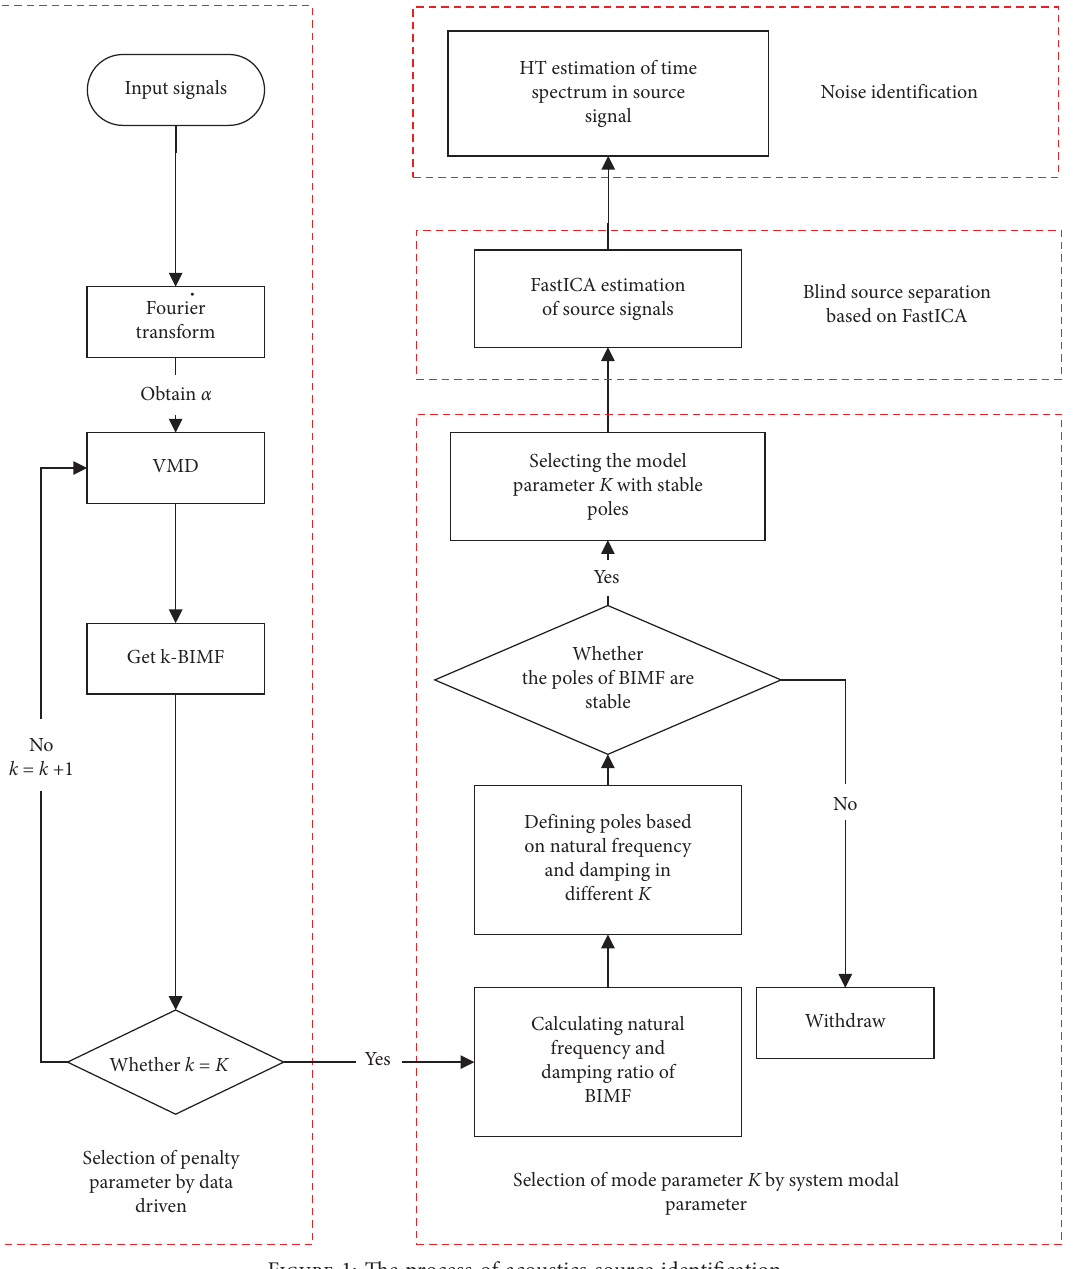
Figure 1: The process of acoustics source identification.